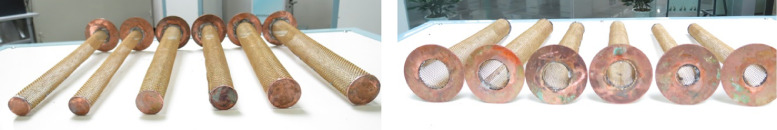
Different dimensions of the copper cylindrical mesh pipes fabricated for the experiment.